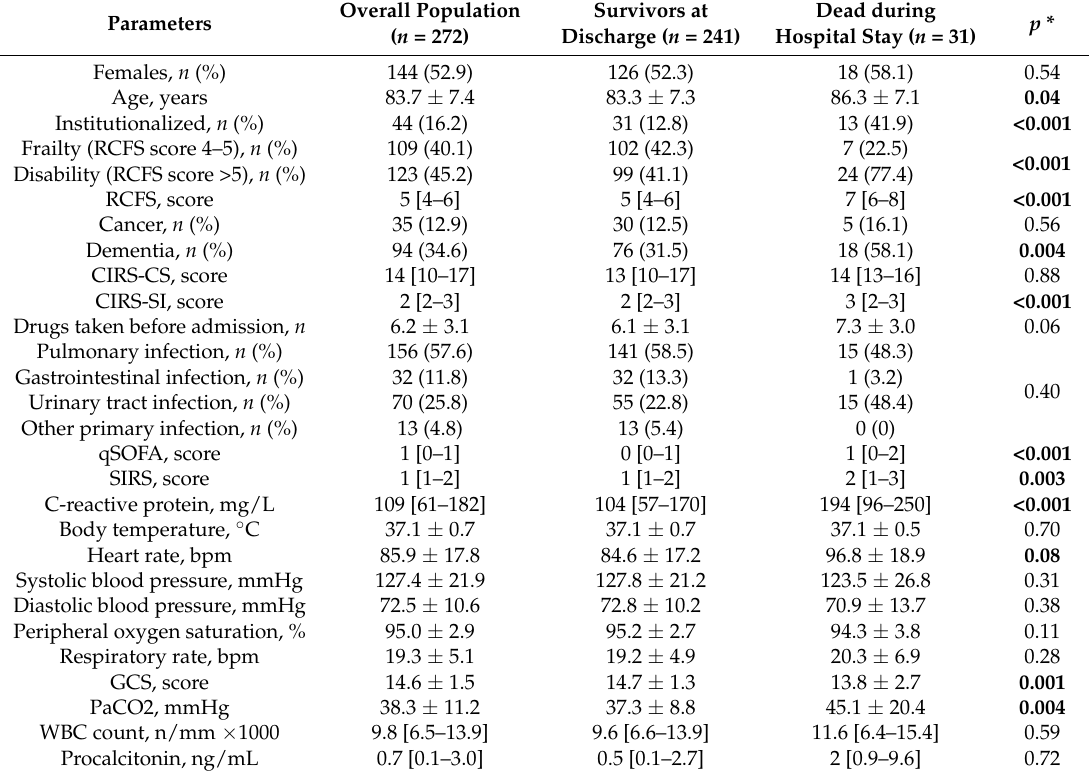
Table 1. Overview of the main characteristics of the studied population of 272 elderly subjects admitted to an acute geriatric hospital ward with suspected sepsis. A comparison of baseline characteristics between patients discharged alive ( n = 241) and patients deceased during hospital stay ( n = 31) is also shown.